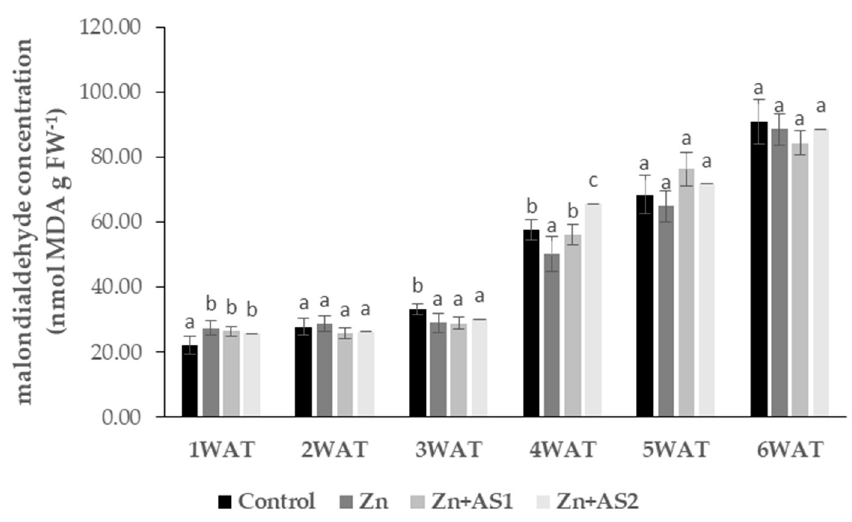
Figure 7. The effect of different foliar treatments (Zn, Zn+AS1, and Zn+AS2) on the malondialdehyde concentration of corn leaf, n = 12 ± S.D. Lower case letters (a, b, and c) show the significant differences among treatments based on the independent t-test ( p < 0.05). AS: amino acid; FW: fresh weight; Zn: zinc; WAT: week(s) after treatment.